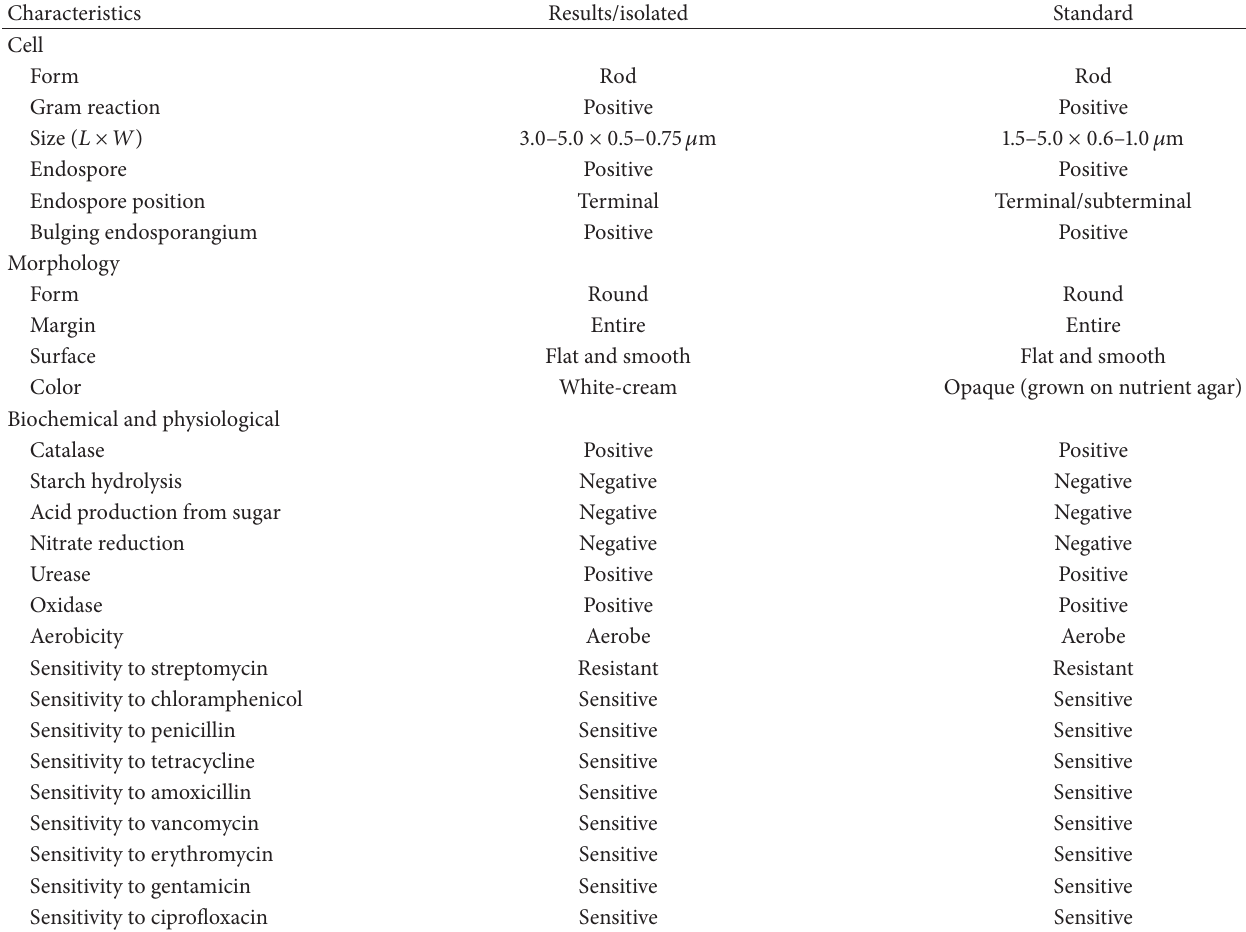
Table 1: Characteristics of B. sphaericus isolated from Lombok Island.